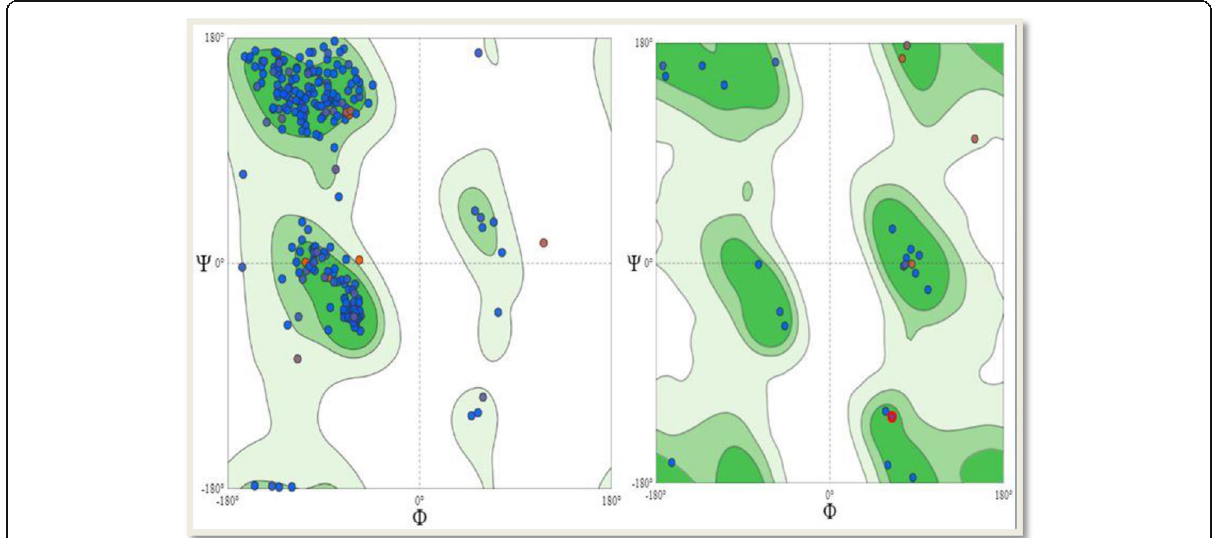
column) and their primary sequence alignment (right column). The target protein is colored in grey while its protein data bank equivalence is colored in red. The high structural similarity between the two proteins was validated through their sequence alignment which pro- duced 99.34% sequence identity score.